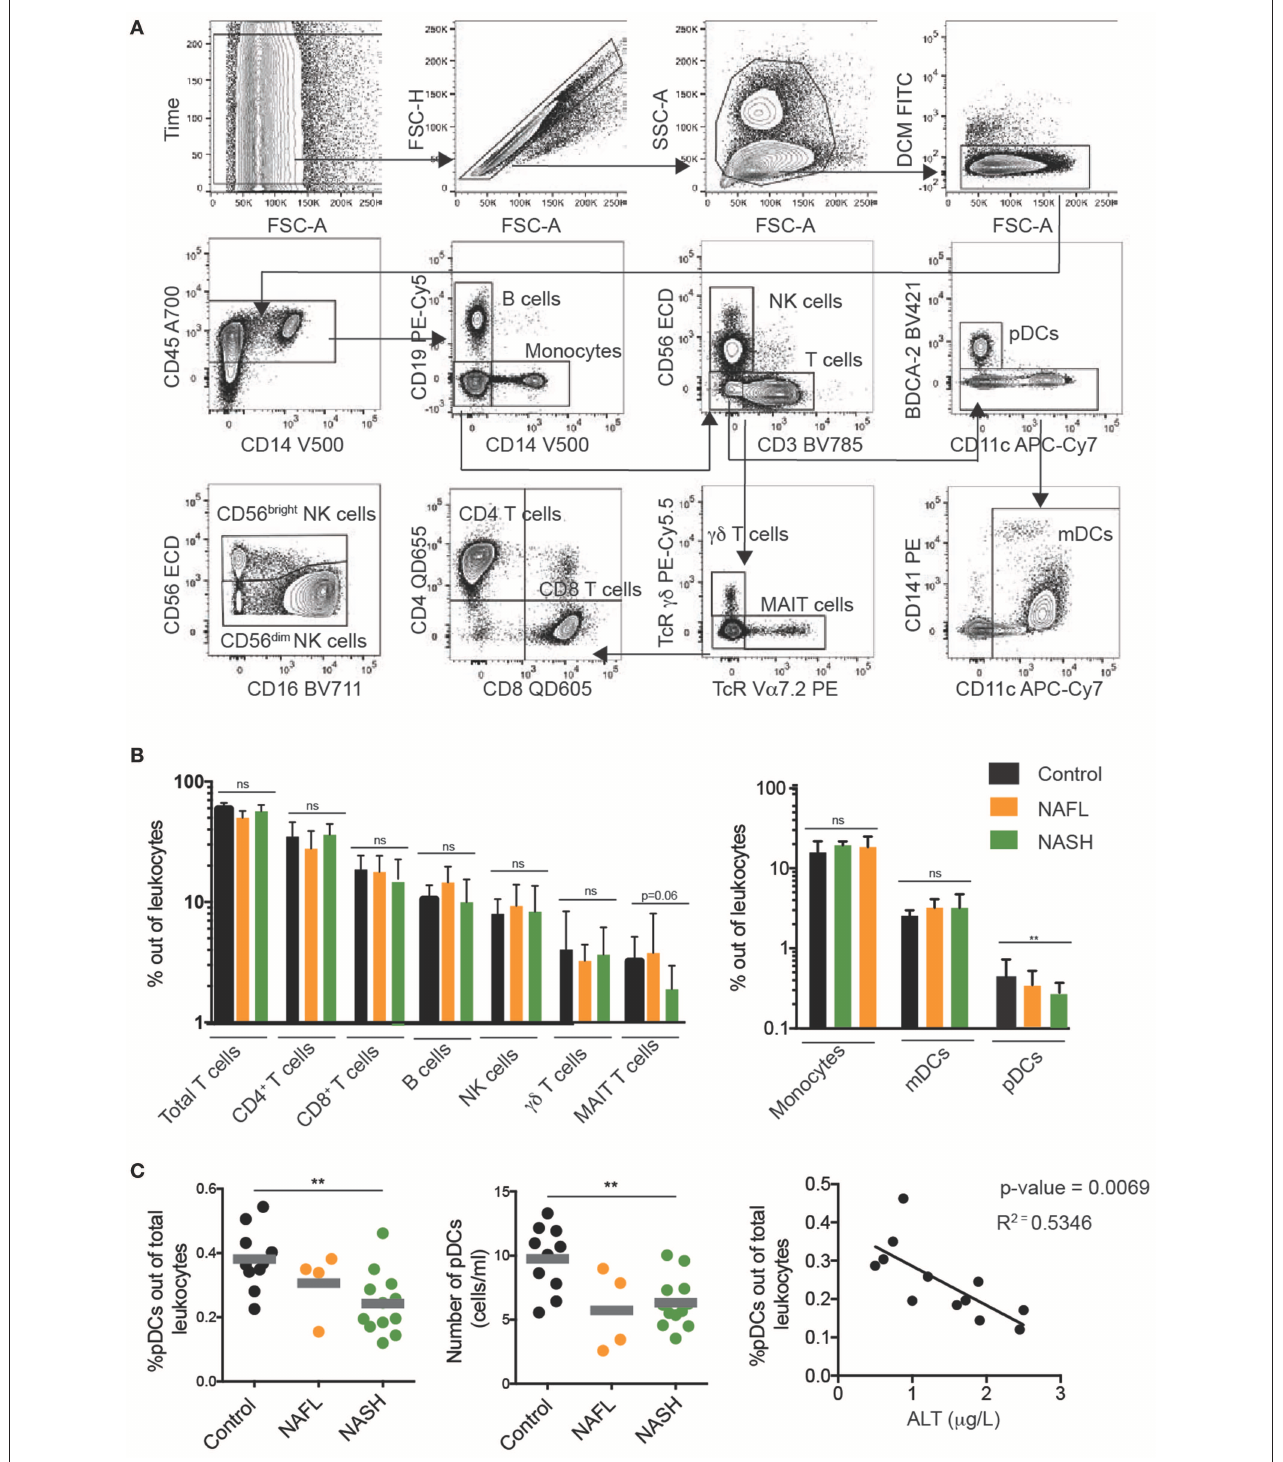
FIGURE 1 | Immunophenotyping of major peripheral blood immune cell subsets in NAFL and NASH. (A) Flow cytometry gating scheme used to identify the investigated immune cell subsets. Arrows indicate the sequence of gating. (B) Summary data for the frequency out of total leukocytes for the indicated immune cell populations in healthy controls ( n = 10), NAFL ( n = 4), and NASH ( n = 11) patients. (C) Summary data of pDC frequency out of total leukocytes (left), absolute counts of pDCs (middle), and correlation between pDC frequency and ALT (right) in the indicated patient groups. Bars in (B,C) represent mean and error bars show SEM. ** p <